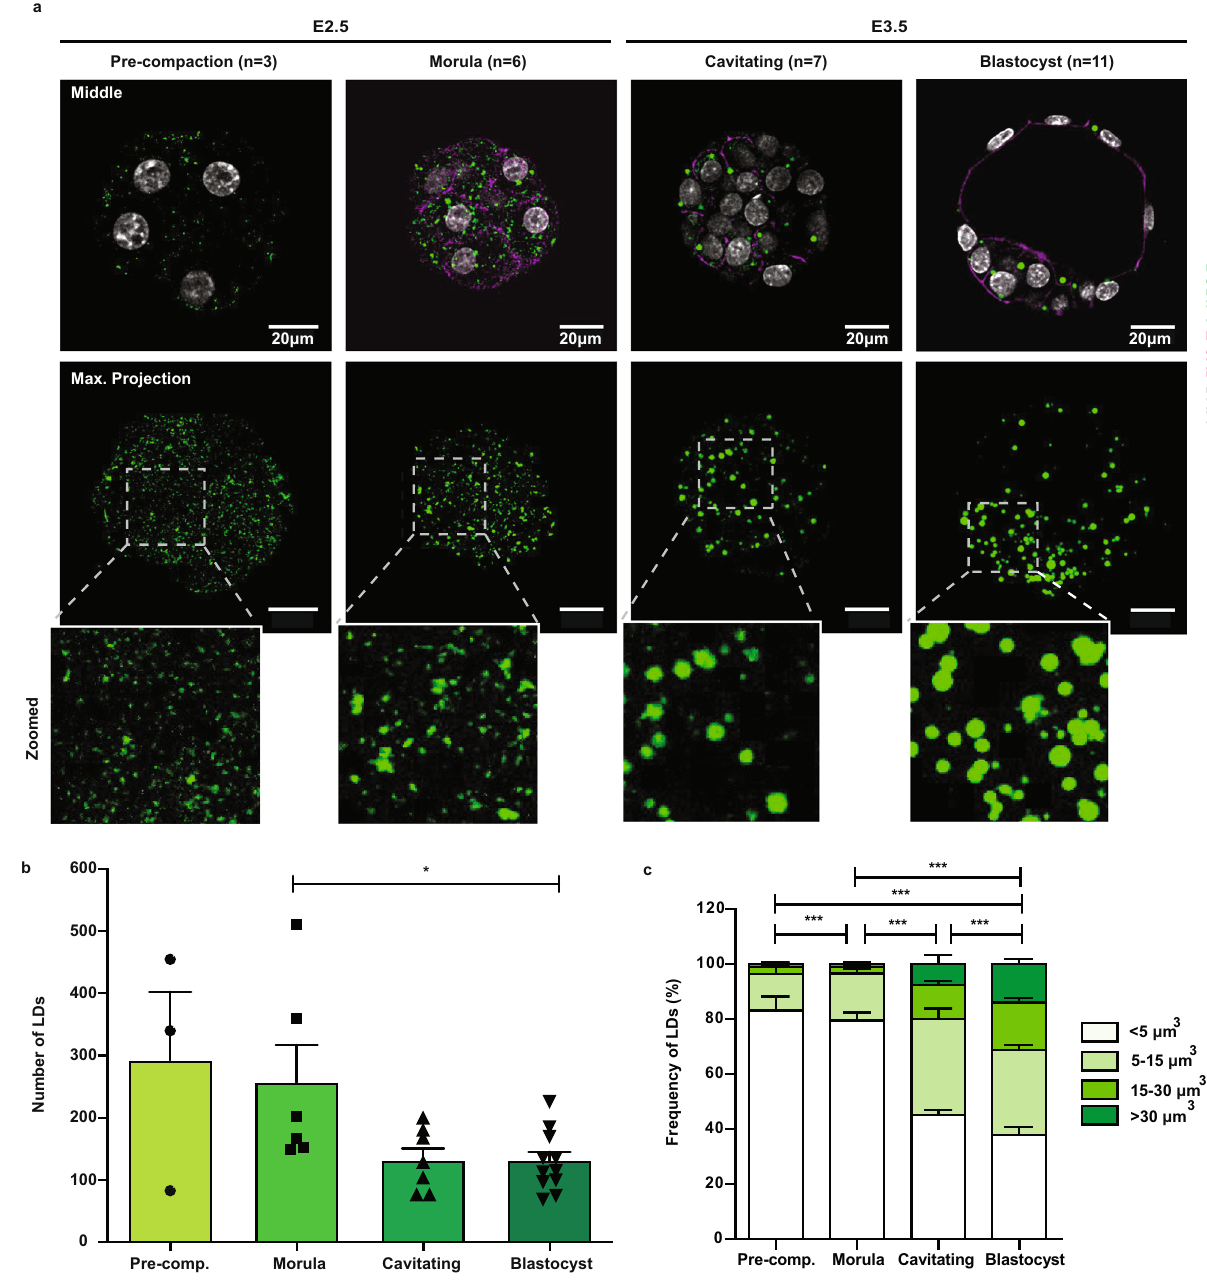
Fig. 1 The ability to fuse and enlarge lipid droplets is acquired by the mouse embryo at the morula-to-blastocyst transition. a Images of BODIPY 493/ 503-stained lipid droplets (LDs) in in vitro pre-implantation embryos cultured from 4 to 8 cell stages (~68 h post-hCG injection) in KSOMaa medium. Adherens junctions were labelled by immunostaining against E-CADHERIN ( n = 3 – 11 embryos). Squares indicate magni fi ed regions, showing LD morphology and enlargement. E, embryonic day of development. E2.5, ~74 h post-hCG injection; E3.5, ~98 h post-hCG injection. Quanti fi cation of b total number of LDs per embryo and c volume of LDs in embryos from ( a ). Each symbol represents one embryo. Error bars, means ± s.e.m.; two-sided Mann – Whitney U test; * p < 0.05; *** p < 0.001. Exact p -values: b p = 0.0237, and c pre-comp. vs morula, p = 0.0004; pre-comp. vs blastocyst, p = 3.9 × 10 − 64 ; morula vs cavitating, p = 4 × 10 − 43 ; morula vs blastocyst, p = 1.3 × 10 − 60 ; cavitating vs blastocyst, p = 4.2 × 10 − 8 . Source data are provided as a Source data fi